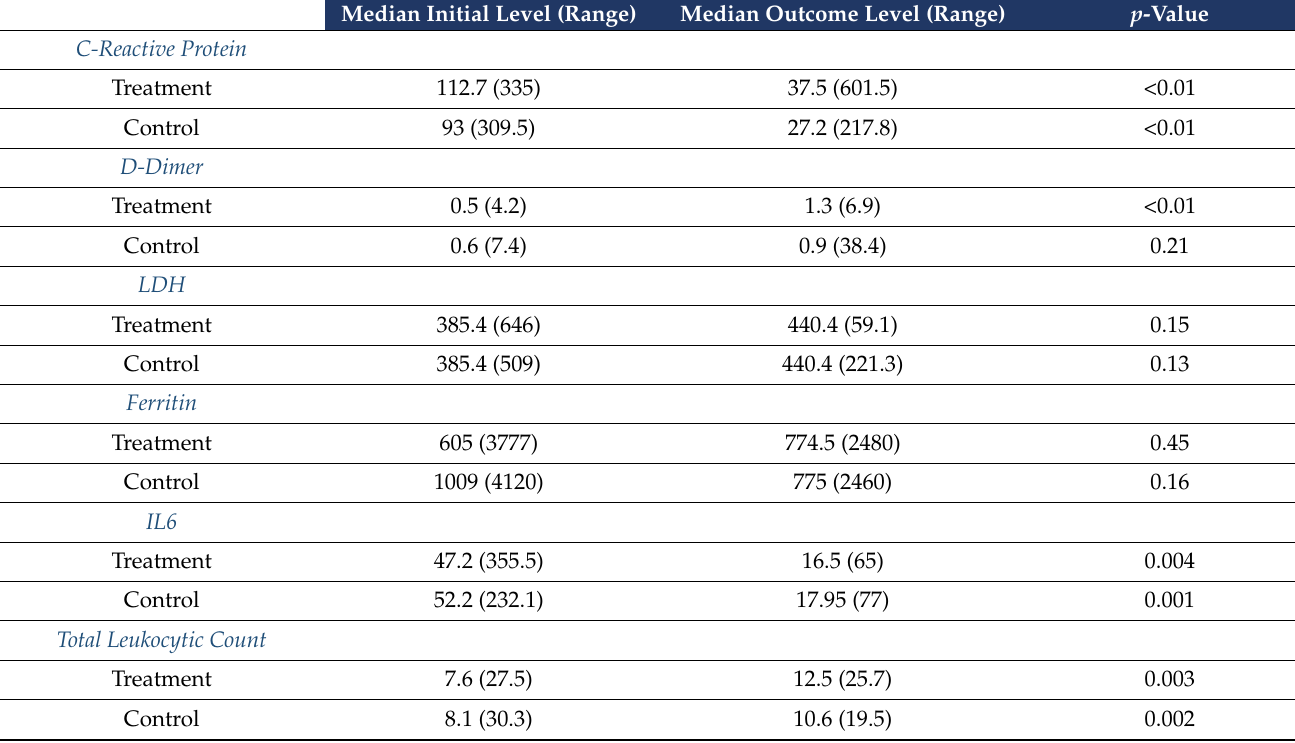
Table 3. Initial and outcome laboratory values comparison between two